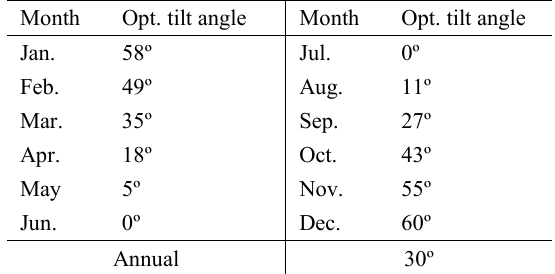
Figure 10. Monthly optimal tilt angle using MATLAB for Najaf city. Table 4. Monthly optimal tilt angle using MATLAB for Najaf